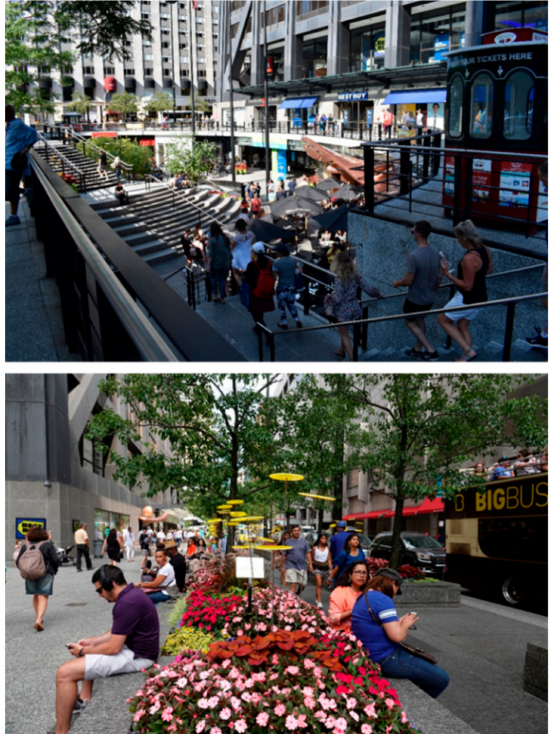
Figure 11. A cluster of plazas near the northern end of the Magnificent Mile o ff ers pedestrians relaxing places. Study participants liked the John Hancock Plaza, shown in the